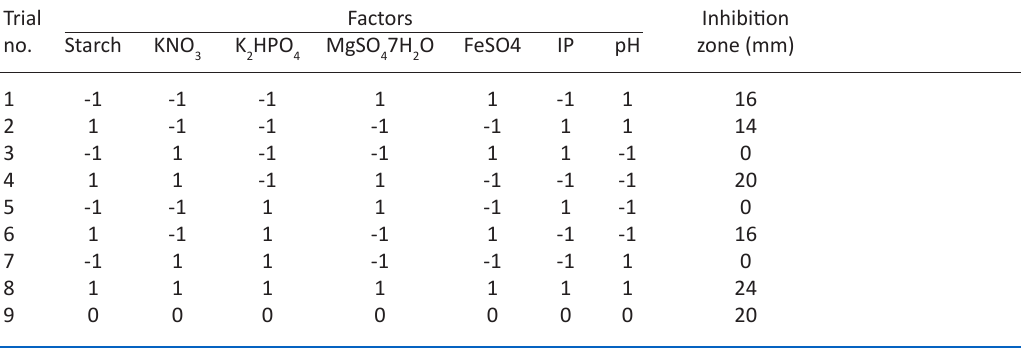
Table 2. The Plackett-Burman design for 7 independent variables against Candida albicans ATCC10231. Trial Factors Inhibition no.